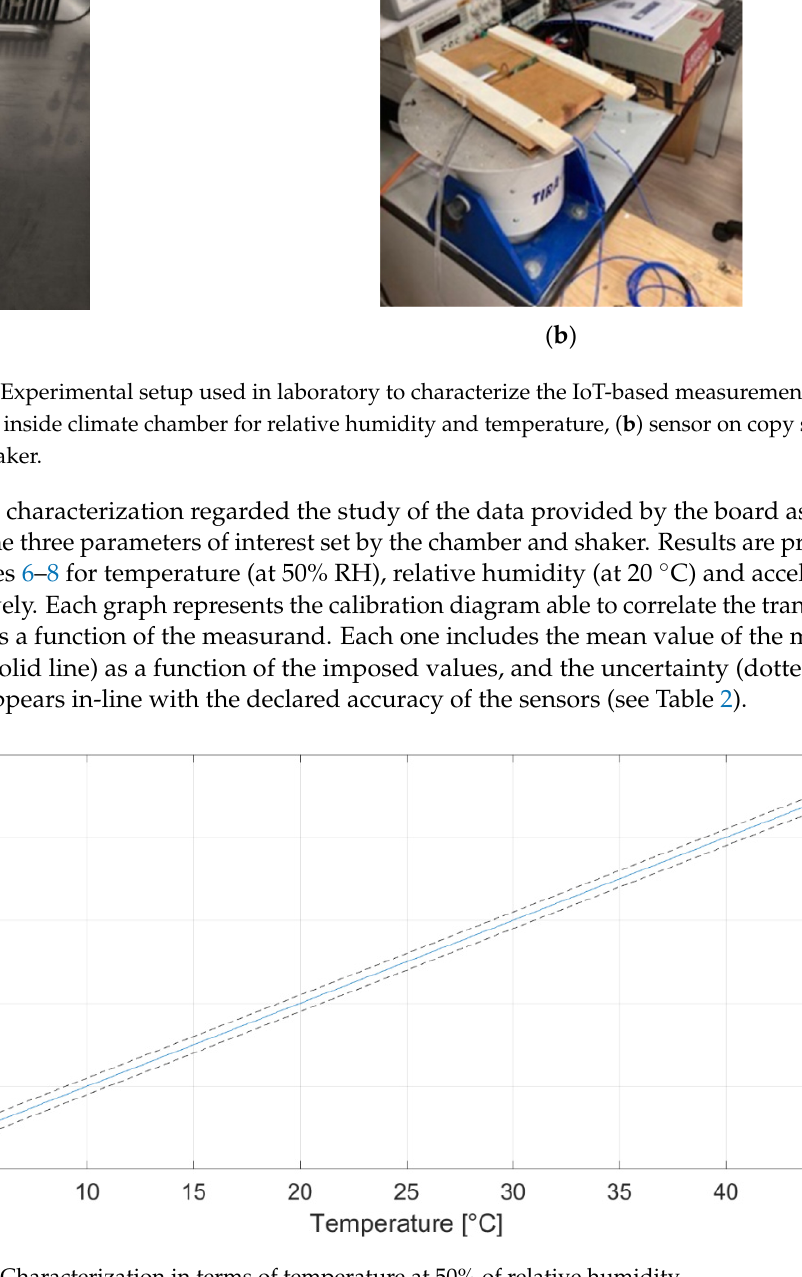
Figure 7. Characterization in terms of relative humidity at 20 °C.